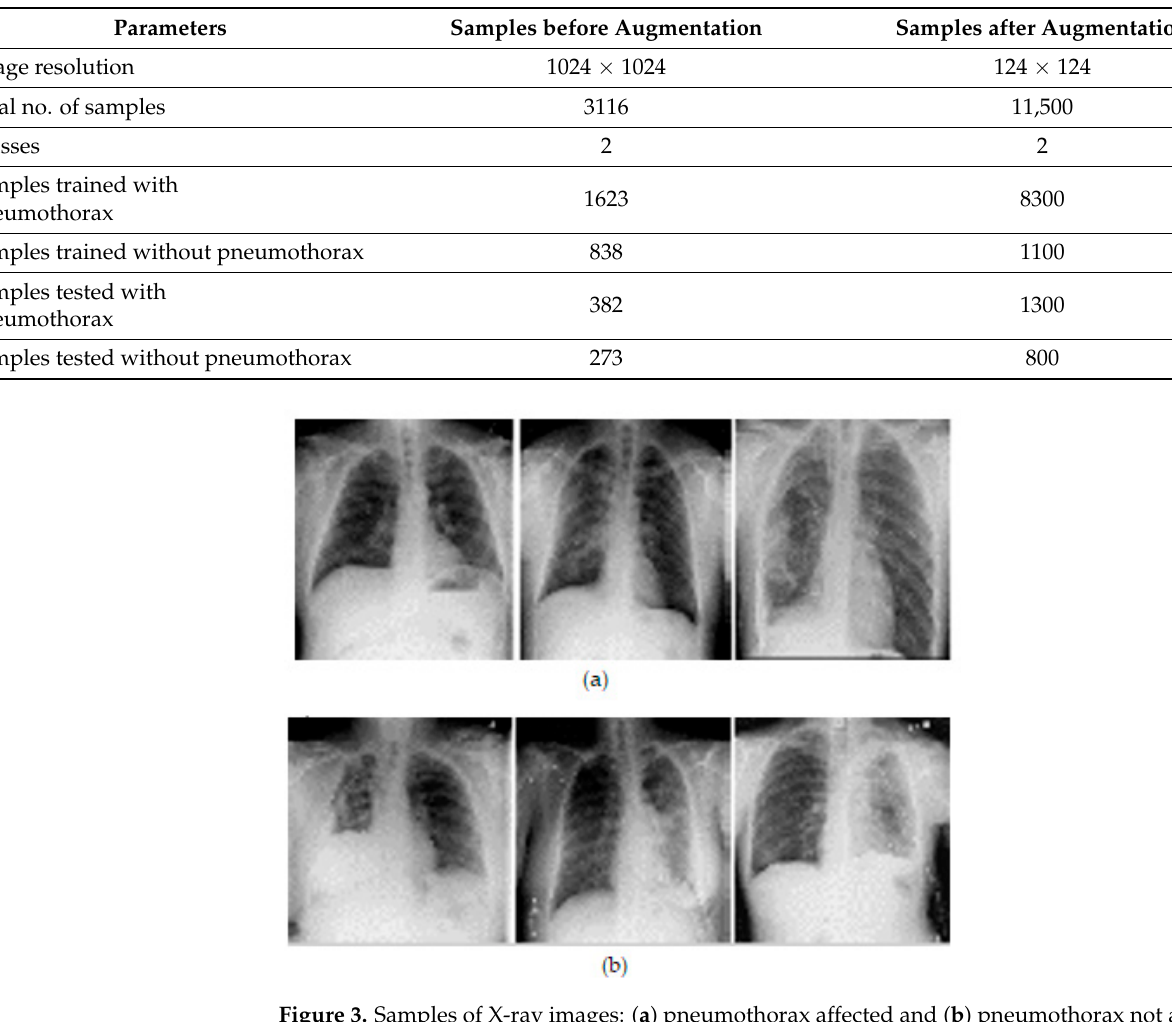
Table 2. Dataset parameters.